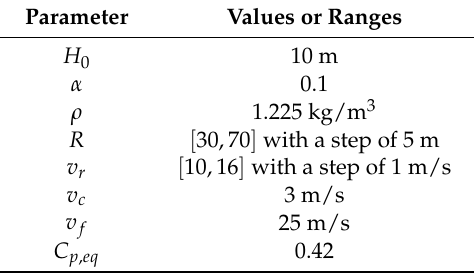
Table 1. Parameters used in the proposed COE minimization